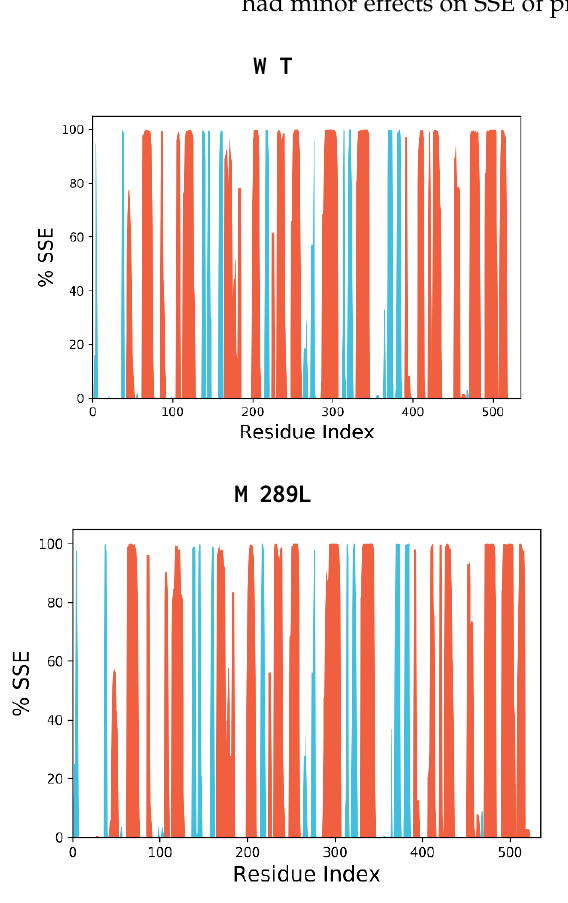
Figure 10. Protein SSE for the WT, T179A, and M289L systems during MDS. The alpha helices, beta sheets, and random coil were represented by red, blue, and white spaces.